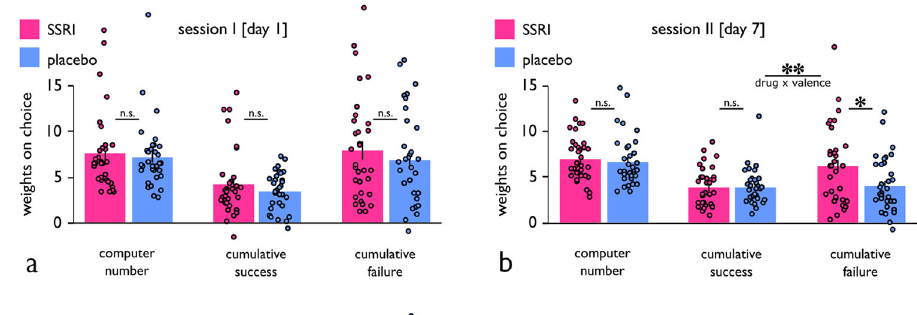
Fig. 2 Results of trial-by-trial logistic regression model. Fitting a logistic regression model to subjects ’ decisions showed that participants gambled more against lower computer numbers, with no drug differences on session I ( a ), and session II ( b ), respectively. Additionally, subjects, over the course of a session, gambled more with increasing success with each deck, and gambled less with increasing failure with each deck. On session I, impact of cumulative success and failure was unaffected by treatment ( a ). On session II, however, SSRIs enhanced the impact of failure but not wins ( b ), indicating an asymmetric drug effect on reward and punishment. ** p < 0.01, * p < 0.05, n.s. = not signi fi cant ( p > 0.05). Error bars